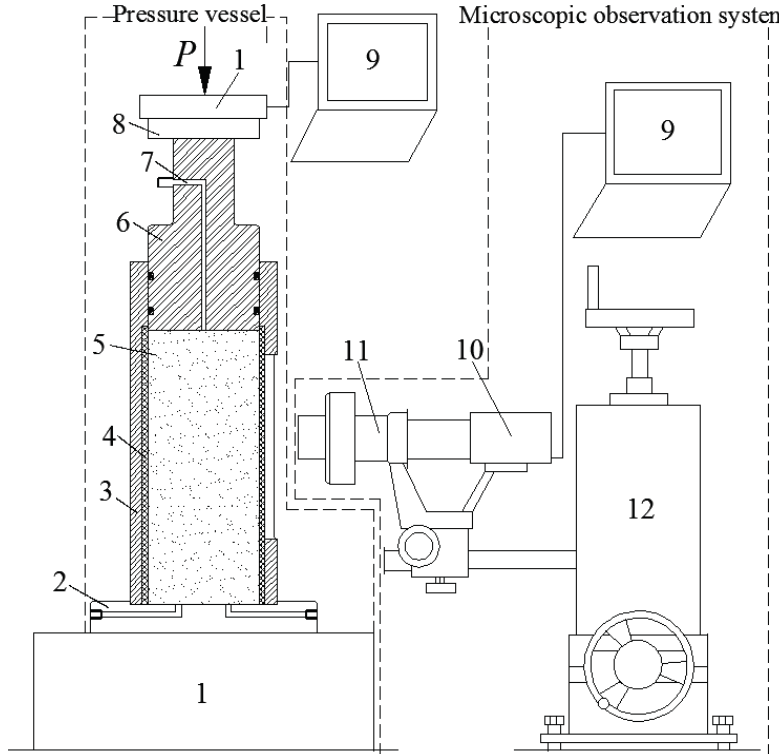
Figure 2. The testing apparatus: 1, testing machine; 2, bottom plate; 3, stainless steel cylinder; 4, tempered glass cylinder; 5, tailing specimen; 6, pressure piston; 7, exhaust hole; 8, piston pressure head; 9, computer; 10, CCD (Charge Coupled Device) video camera; 11, stereoscopic microscope; 12, 3D mobile microscope support